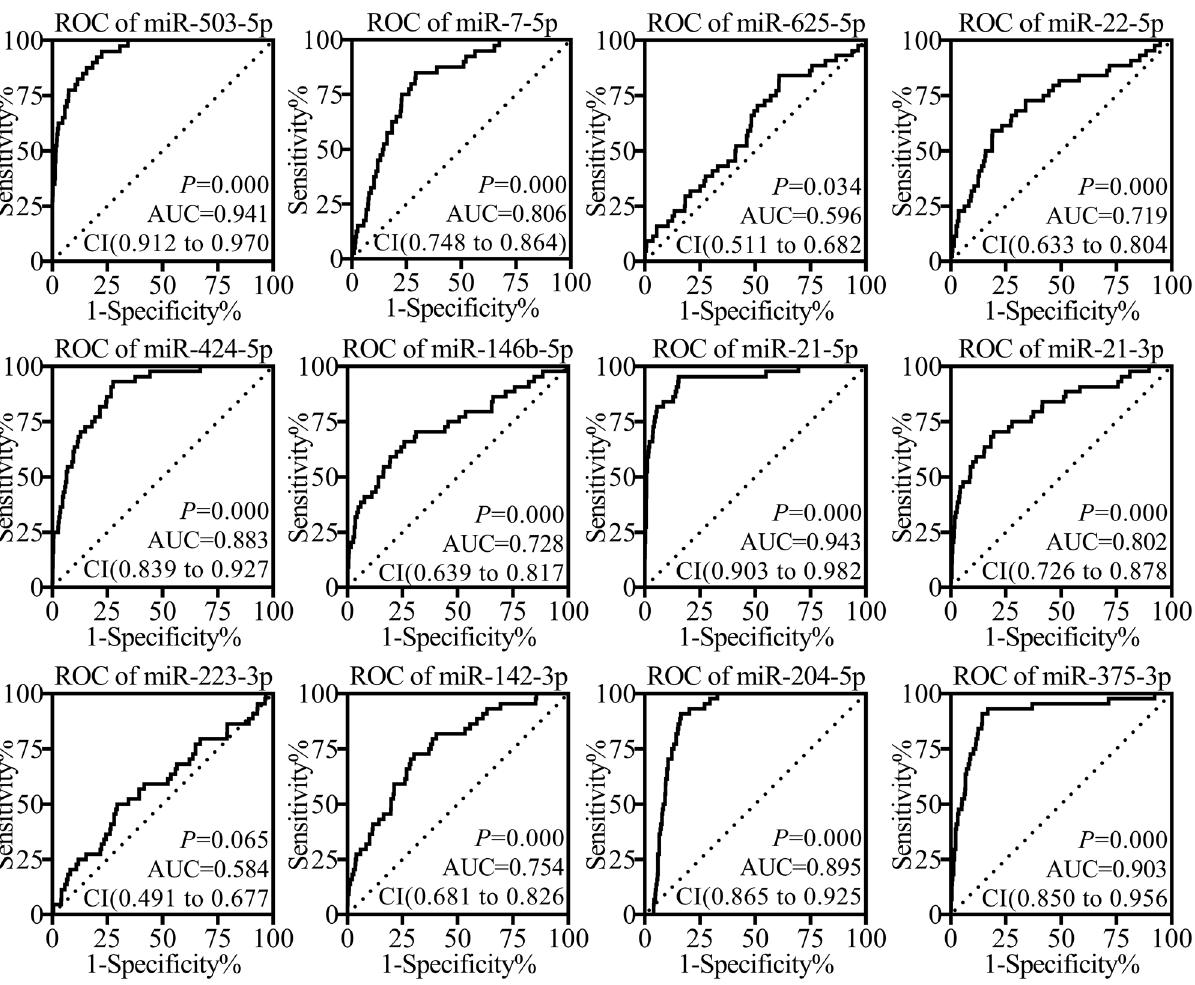
Figure 5: Receiver operating characteristic curves of di ff erential expressed miRNAs. ROC, Receiver operating characteristic, AUC, area under ROC curve. CI, con fi dence interval. A value of p < 0.05 and AUC ≥ 0.85 mean e ff ective diagnostic